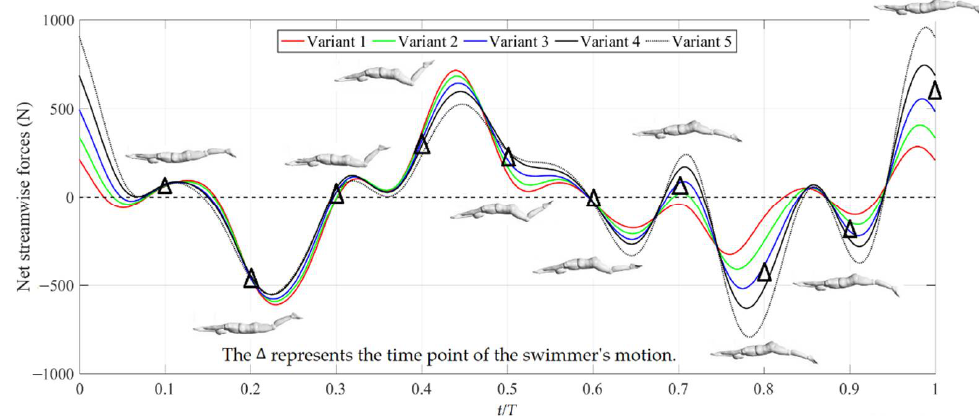
Figure 5. Net streamwise forces of a swimmer in a cycle under different trunk oscillations.